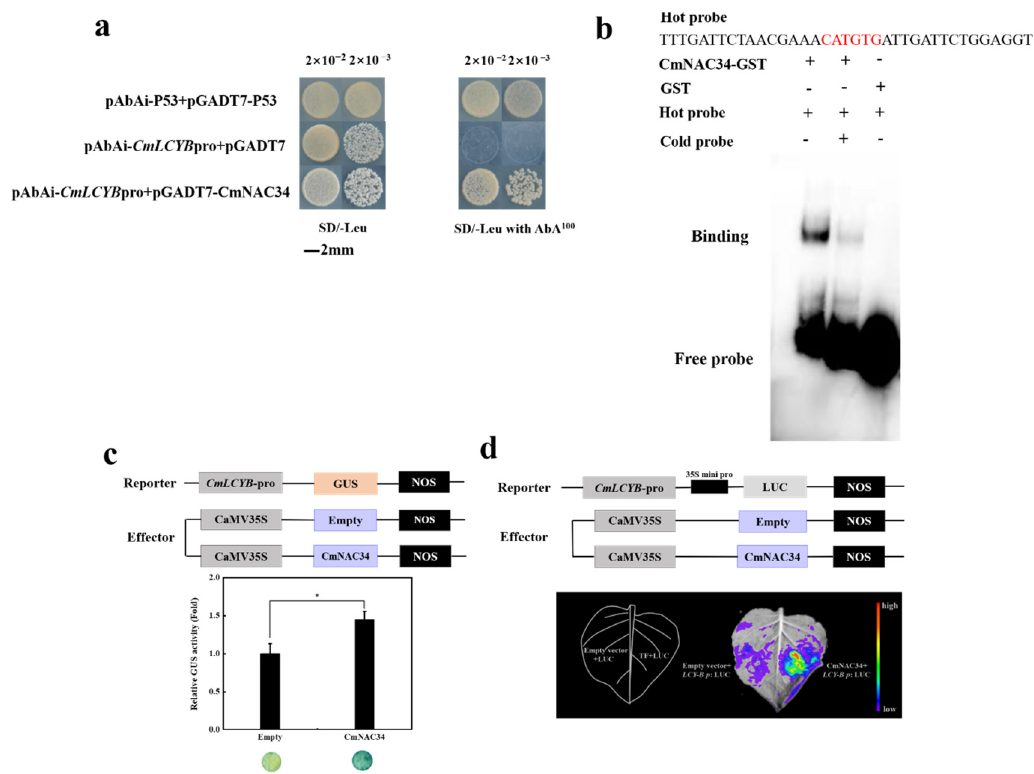
Figure 5. CmNAC34 activates the expression of CmLCYB by interaction with its promoter. ( a ) Y1H assay showed that CmNAC34 binds to the promoter of CmLCYB in the yeast system. SD/-Leu, SD medium deficient Leu; SD/Leu with AbA 100 , SD medium deficient Leu supplemented with 100 ng·mL − 1 of AbA. The transformed yeast cells were dripped at 2 × 10 − 2 and 2 × 10 − 3 on the selective medium, respectively. ( b ) EMSA shows that the CmNAC34 binds to the CATGTG motif in the CmLCYB promoter. ( c ) Schematic diagram of reporter and effector constructs in GUS assay. The reporter and effector were co-infiltrated into tobacco leaves to analyze the regulation of GUS activ- ity. ( d ) Schematic diagram of reporter and effector constructs in a luciferase reporter assay. The reporter and effector were co-infiltrated into tobacco leaves, and this assay showed CmNAC34 pos- itively regulated CmLCYB expression. The colors represent the gene expression abundance. Three independent injected tobacco leaves were performed, and the error bar represents the SE. Asterisks indicate a significant difference compared to control, as determined by the independent sample t - test (* p < 0.05).